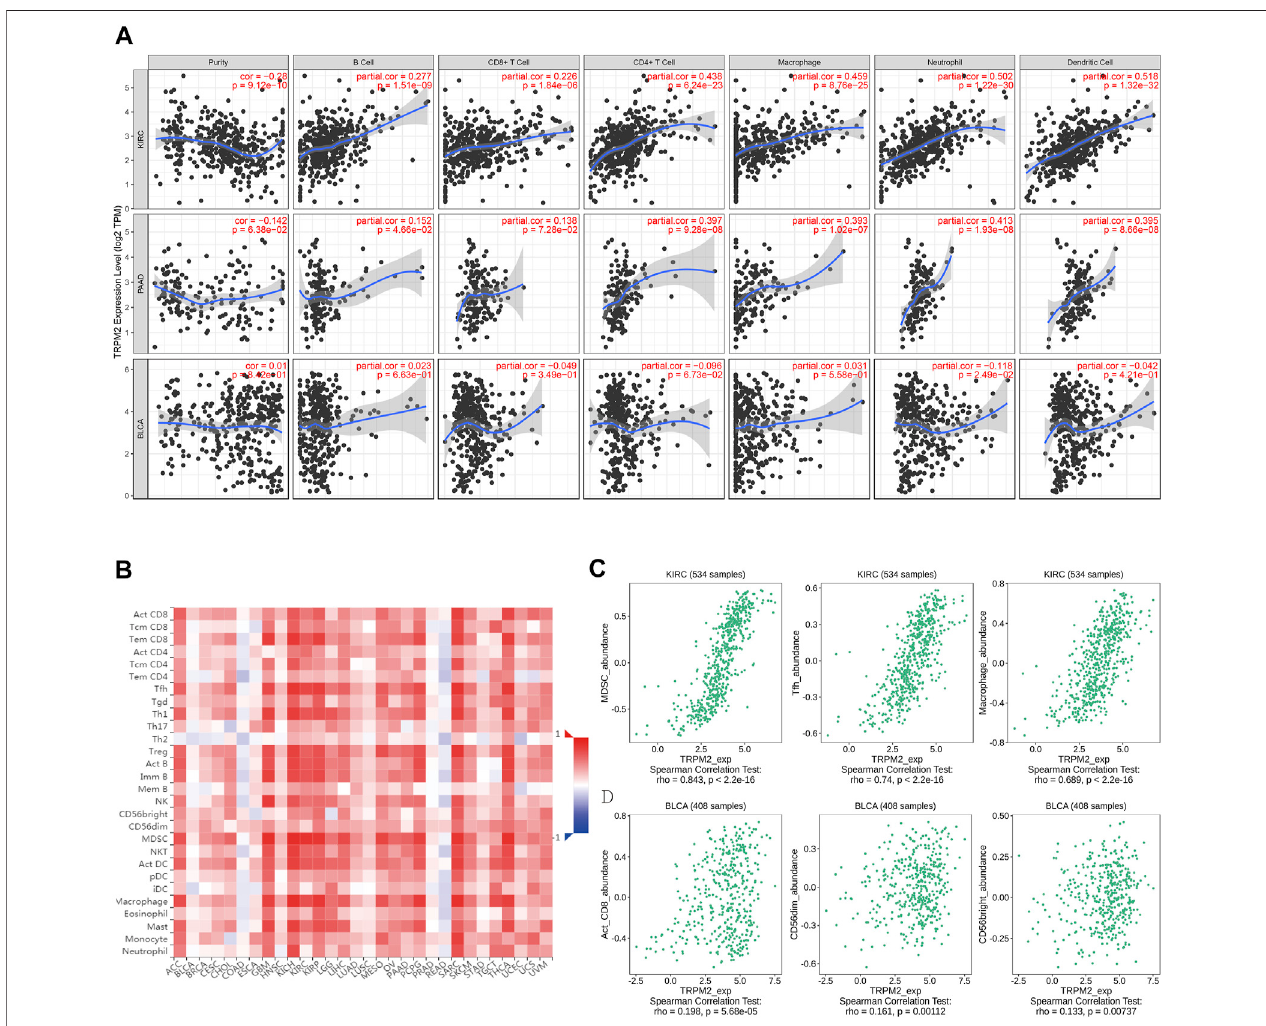
FIGURE 5 | Correlation analysis between the expression level of TRPM2 and immune cell in fi ltration. (A) Correlation between the expression level of TRPM2 and tumor purity, in fi ltrating levels of B cells, CD8 + T cells, CD4 + T cells, macrophages, neutrophils, and dendritic cells in kidney renal clear cell carcinoma (KIRC), pancreatic adenocarcinoma (PAAD), and bladder urothelial carcinoma (BLCA) displayed using the TIMER 1.0 database. (B) Correlations between the in fi ltration level of tumor immunecellsandtheexpressionlevelofTRPM2acrosshumancancersintheTISIDBdatabase. (C , D) Top3typesofTRPM2-correlated immunecellsinKIRC (C) and BLCA (D) using the TISIDB